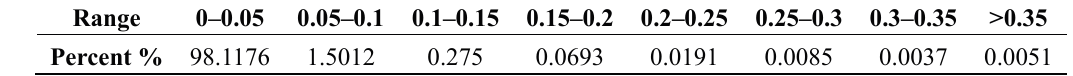
Table 4. Distribution range of RMSEs in 2000.